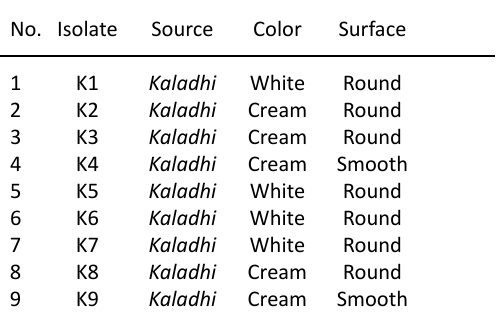
Table 2. Biochemical characteristics of microbial isolates